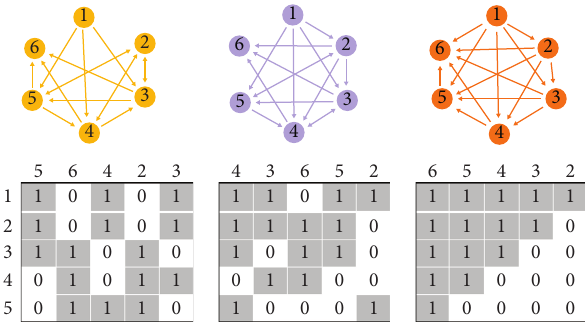
Figure 1: Three representations of matrices, respectively, correspond to none, moderate, and perfect nested network. (a) These three networks have the same number of nodes and links. (b) In each matrix, the rows and columns have been ranked by the number of ones (i.e., degree). In a perfectly nested matrix, the upper-left triangle would be full of elements and the lower-right triangle would have no